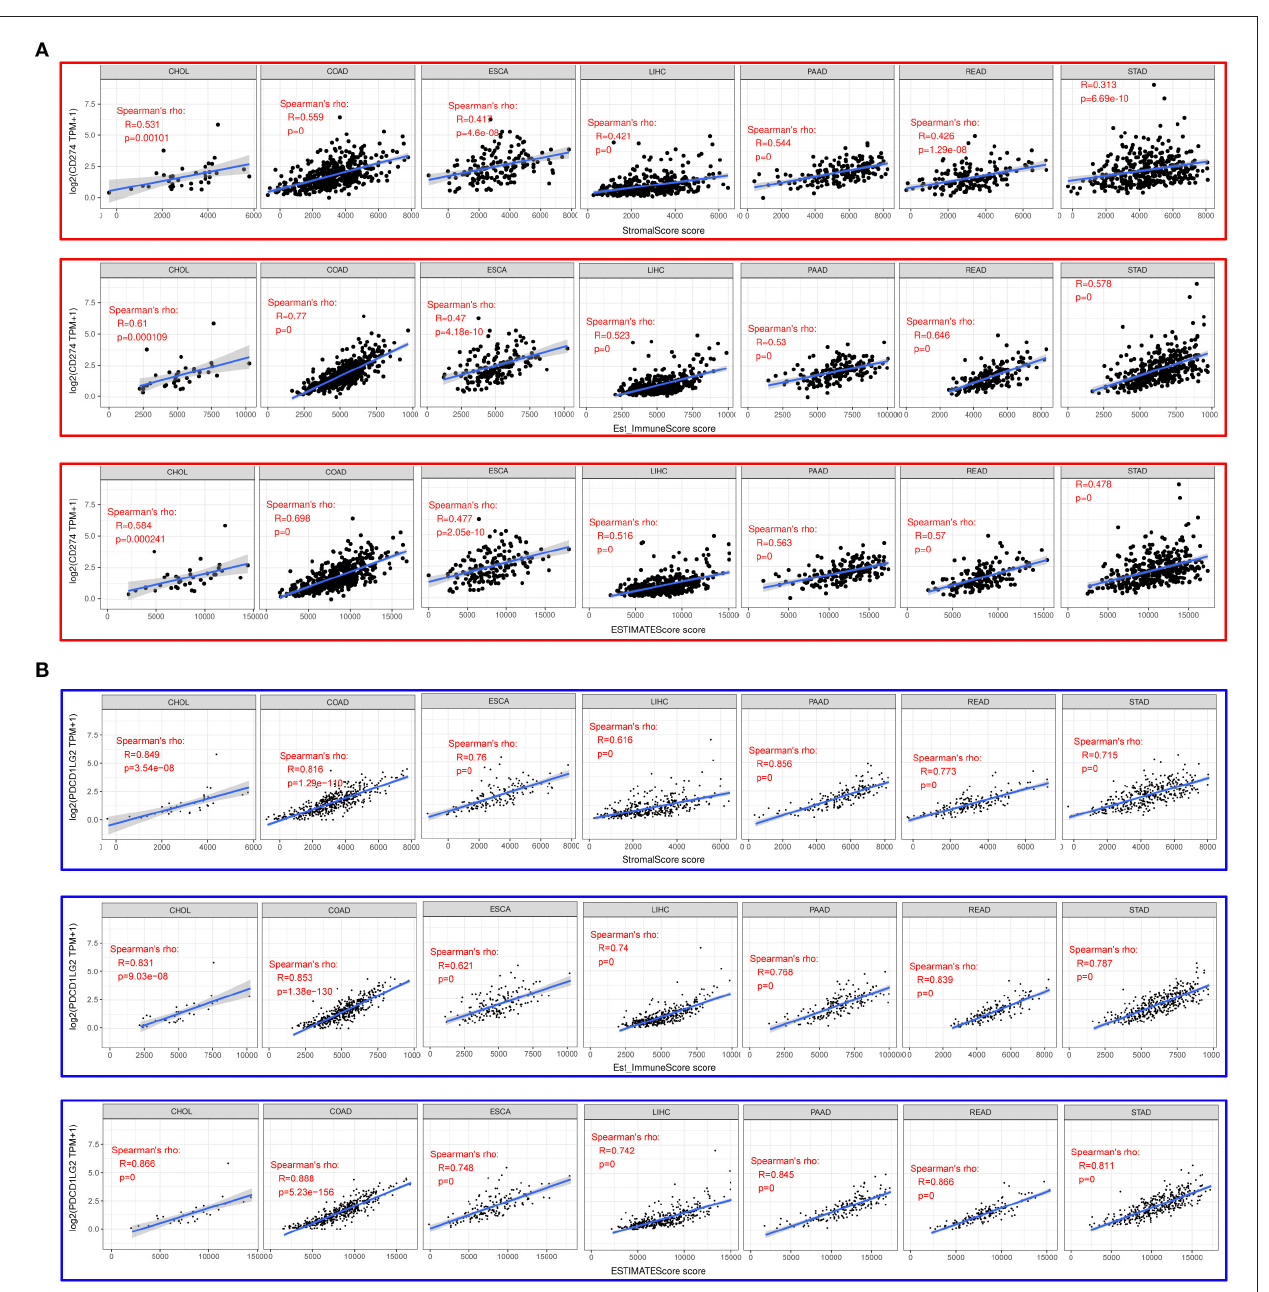
FIGURE 3 | CD274/PDCD1LG2 expression is correlated with cancer immunity in Estimation of STromal and Immune cells in MAlignant Tumor tissues using the Expression data (ESTIMATE). (A) ESTIMATE predicting CD274 expression is correlated with tumor immune infiltration level across seven cancer types. Top panel, stromal score; middle panel, immune score; and bottom panel, estimate score. (B) ESTIMATE predicting PDCD1LG2 expression is correlated with tumor immune infiltration level across seven cancer types. Top panel, stromal score; middle panel, immune score; and bottom panel, estimate score.